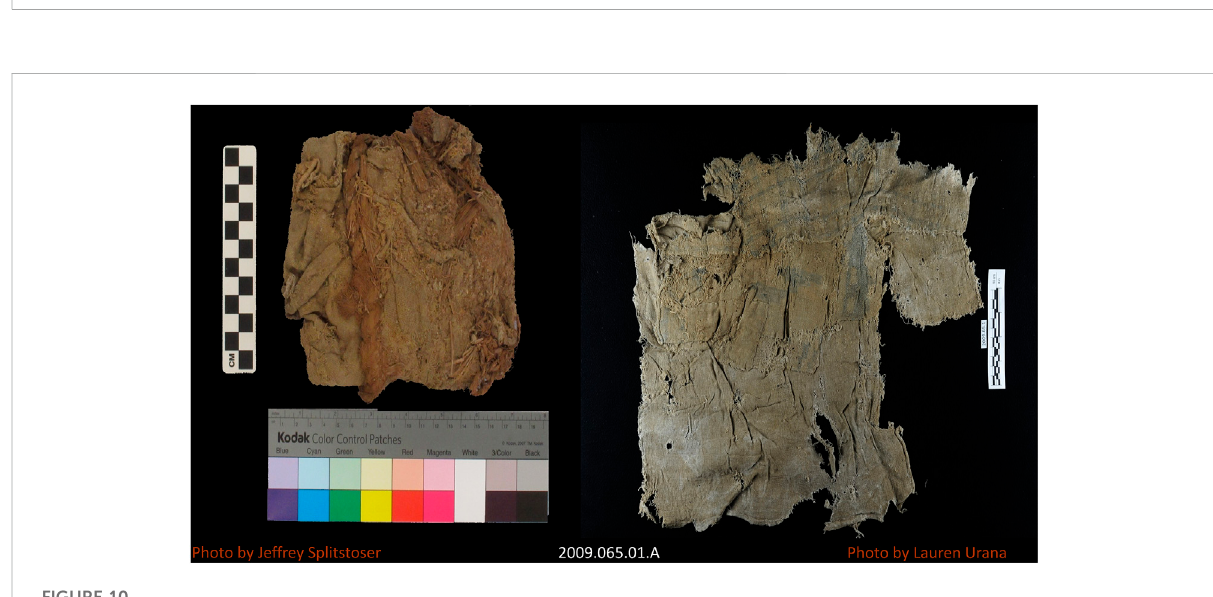
Cotton textiles dated to ~5,800 – 5,500 BP at Huaca